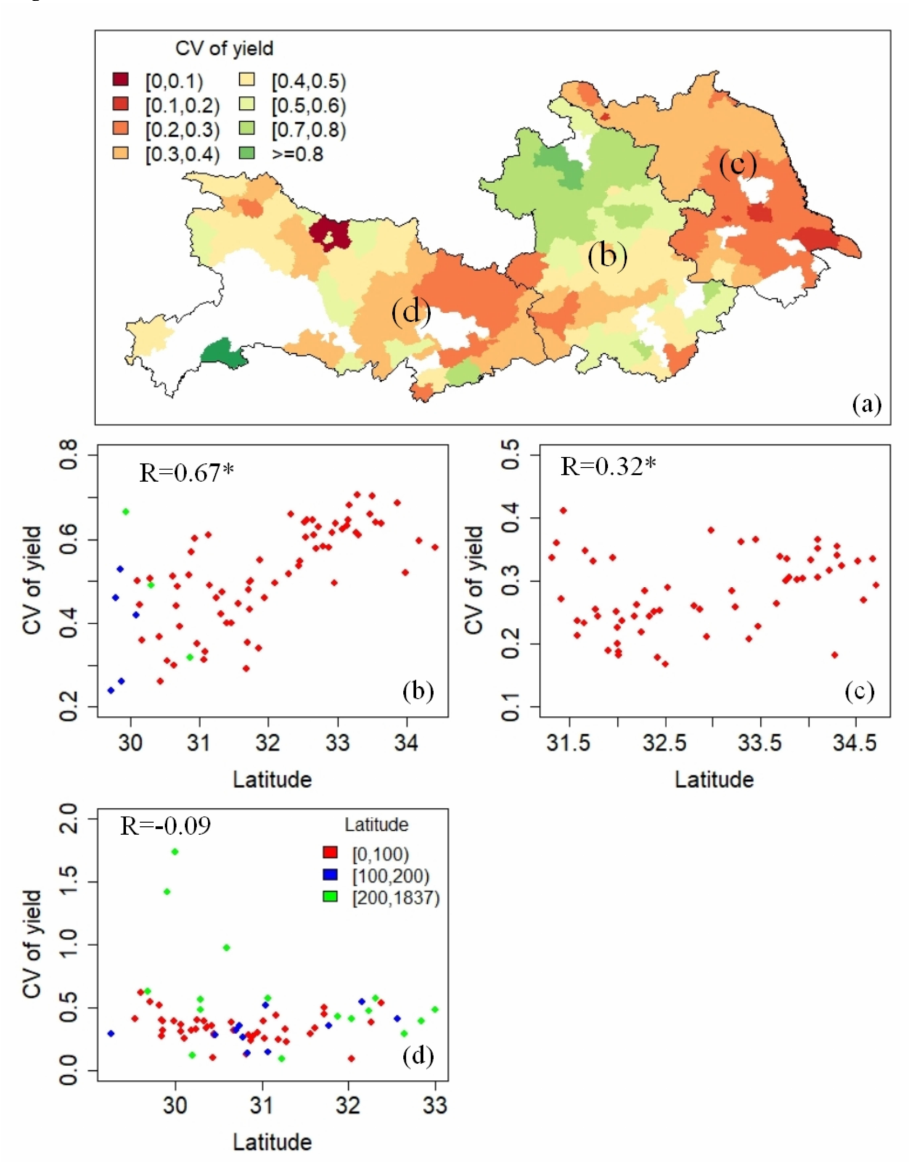
Figure 2. Coefficient of variation (CV) of winter wheat yield over study area ( a ). Scatter plot of CV of yield and latitude were also given for Anhui ( b ), Jiangsu ( c ) and Hubei ( d ). The asterisk (*) indicates that the correlation between them has passed the significance test. Area with blank means no data and the same